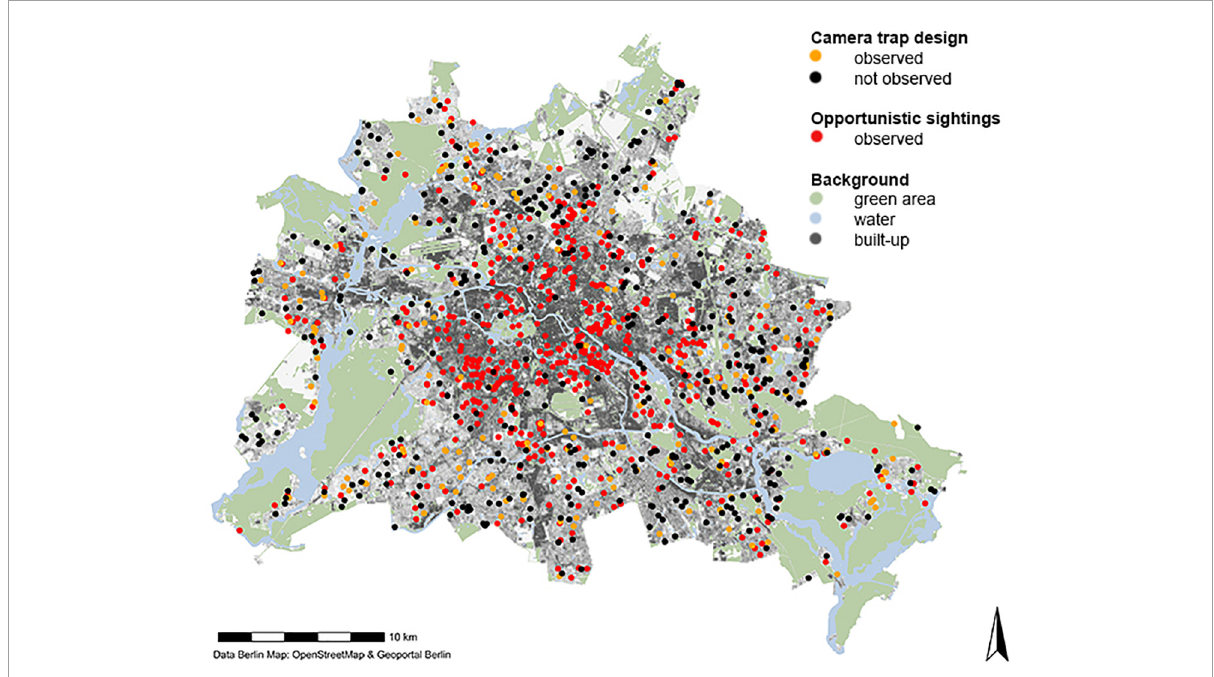
FIGURE1 Study area with sampling locations of red squirrels. Camera trap surveys (black and orange dots) represent a semi-structured sampling design. Unstructured presence-only data (red dots). Background map of Berlin created with R package d6berlin (Scherer